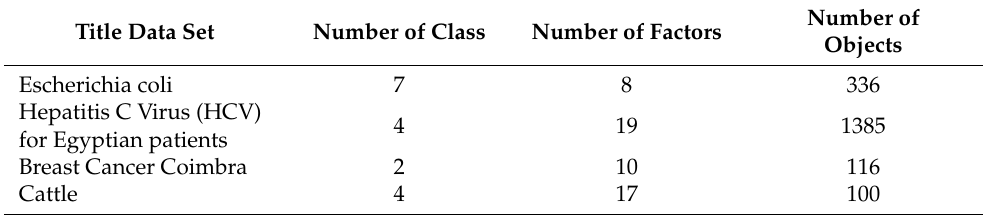
Table 2. Parameters of model tasks and the proposed